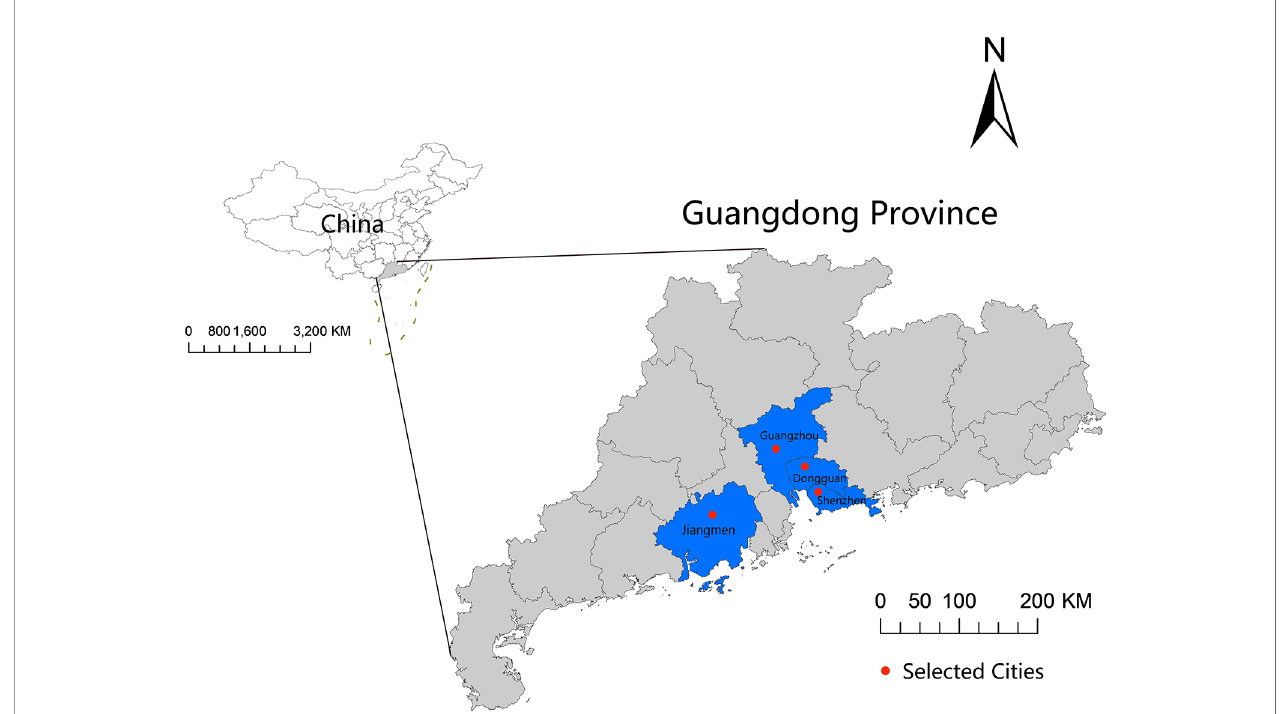
FIGURE 1 | Geographic locations of the four included study cities in Guangdong Province,